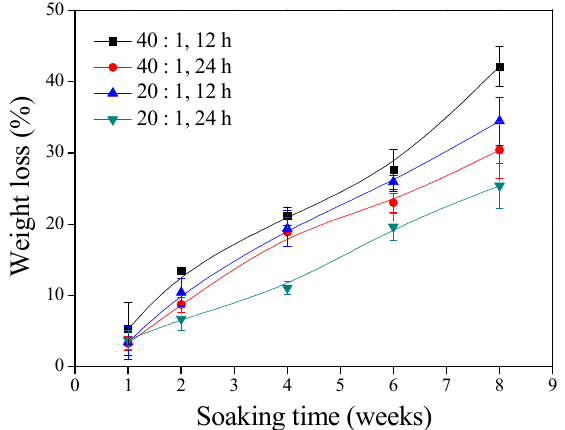
Figure 3. The weight losses of the γ –PGA/ β –TCP composite fibrous mats during the soaking time.